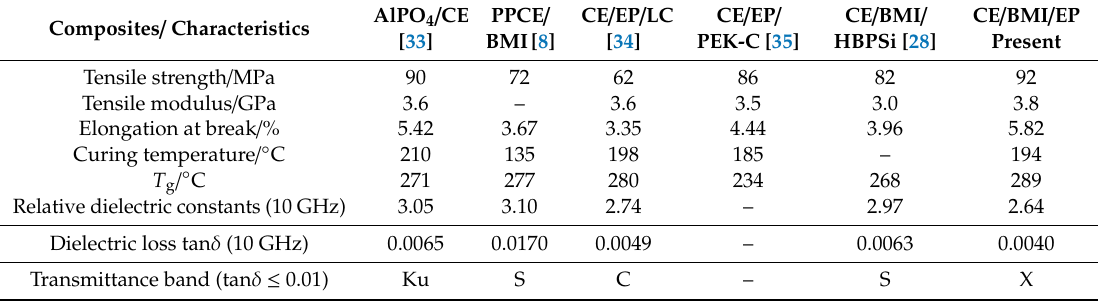
Table 3. Comprehensive characteristics of CE-resin composites for